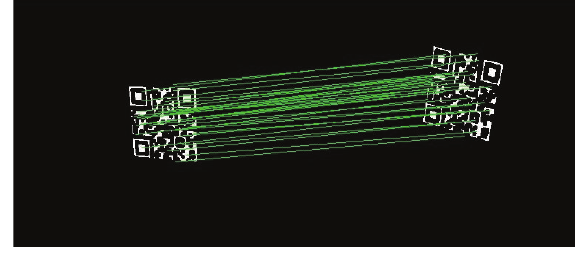
Figure 9: Two images of the object mark corresponding to {𝑐} and {𝑐 󸀠 } , together with the extracted corner correspondences.